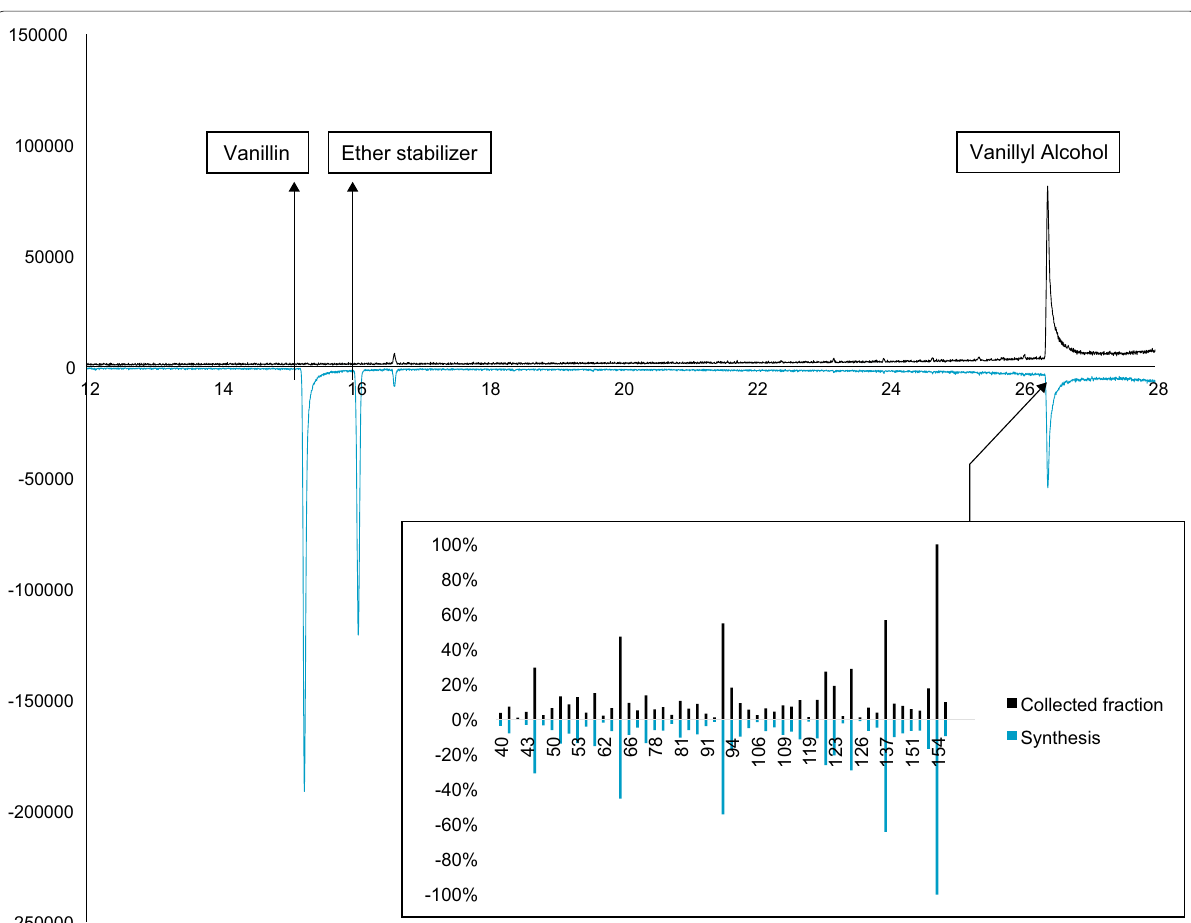
Fig. 2 GC–MS runs of the crude synthate of vanillyl alcohol (lower chromatogram), as well as of the collected fraction from preparatory LC (upper chromatogram) are